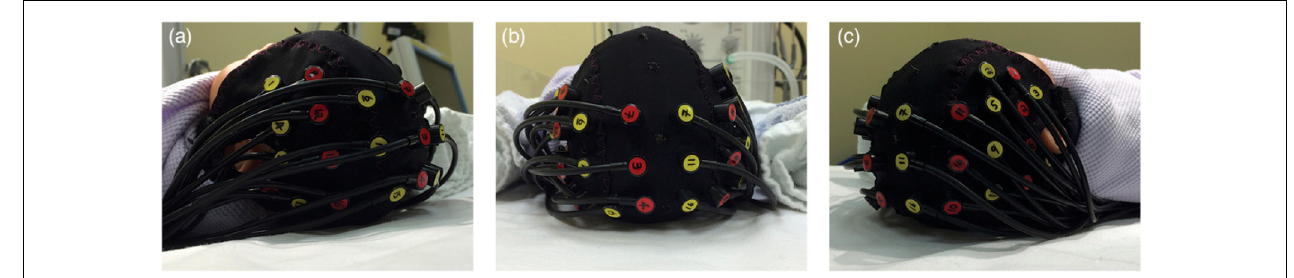
FIGURE 2 | fNIRS-EEG cap arrangement showing the positioning of fNIRS optodes (sources in red, detectors in yellow) on an infant head from (a) left, (b) top and (c) right views.